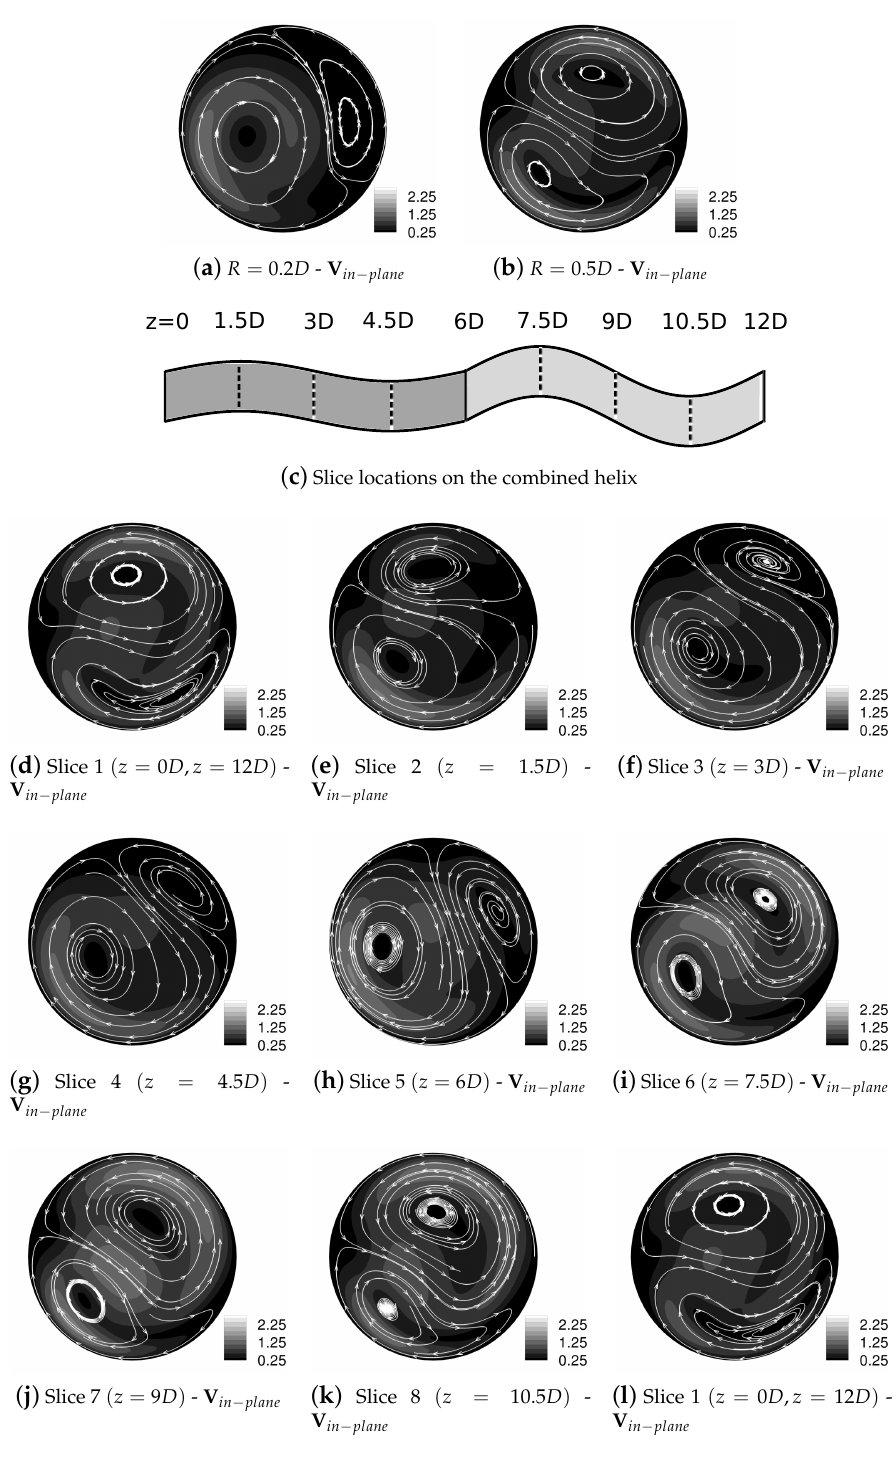
Figure 14. Streamtraces of V in − plane (cm/s) for R A = 0.2 D and R B = 0.5 D , Re = 250. ( a , b ) show the streamtraces from the single helical geometries, with ( d – l ) showing results from the combined geometry. The velocity field at z = 0, in ( d ), in the combined geometry corresponds closely to that for R = 0.5 D , in ( b ), whereas at z = 6 D , in ( h ), the streamtraces are close to those for R = 0.2 D in ( a